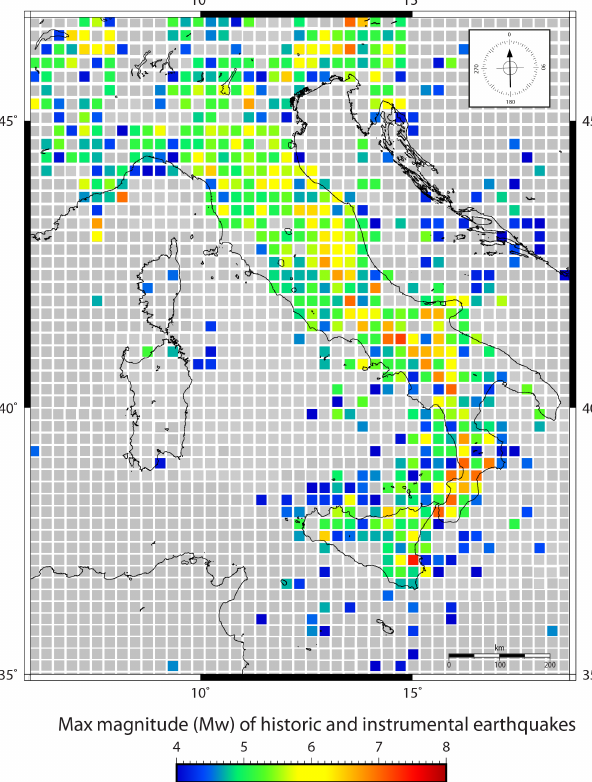
Figure 8. Map of the fault-length earthquake magnitude (FLEM) calculated, for each cell, from the length of class B faults. FLEM values are obtained using L10. Light grey is for cells with no data, whereas light purple is for cells where the longest faults belong to the class A set. Note that these results should be considered more in a theoretical and methodological perspective for comparison with future similar studies rather than in an applicative perspective for the case of Italy. In particular, our assessed earthquake magnitudes for the Italian territory are here proposed for scientific reasons and not for their use for civil protection and prevention purposes.